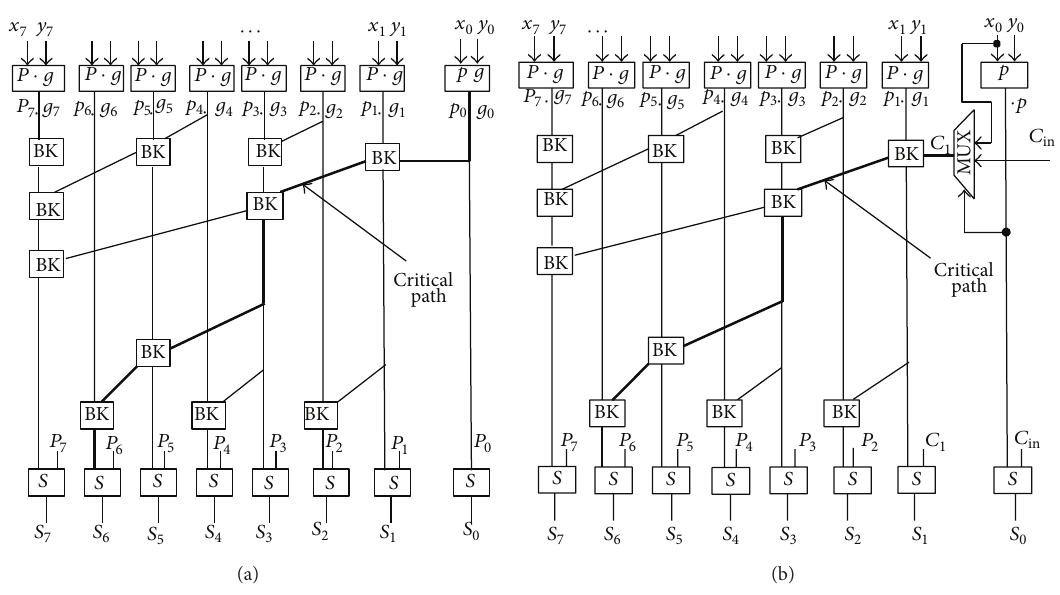
Figure 4: Block circuit diagram of conventional Brent-Kung adder (a) and (b) modifying Brent-Kung adder.